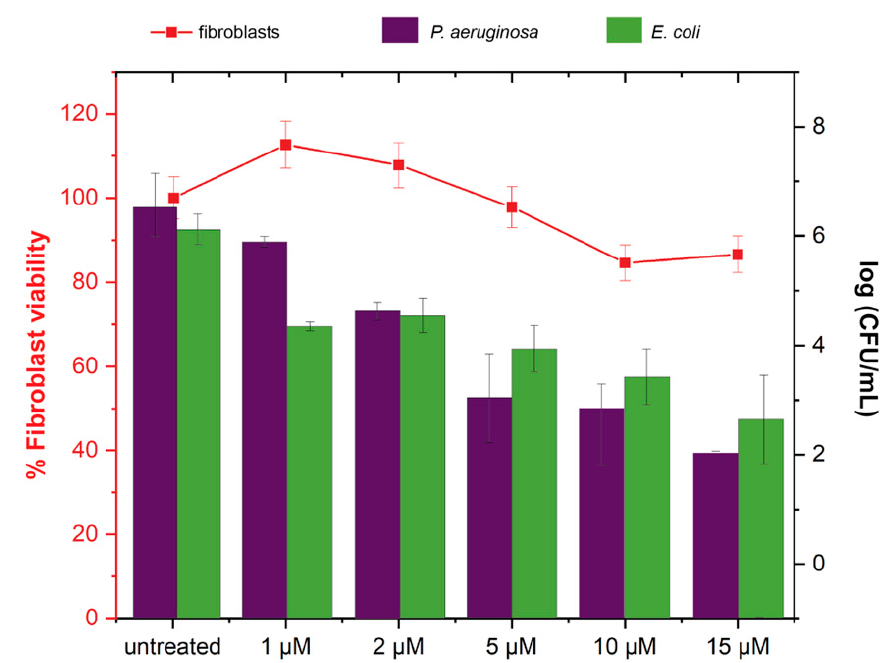
Figure 4. Viability of 3T3 fibroblast cells and E. coli DH5 α + P. aeruginosa ATCC-19660 dual-species biofilms in the co-culture model after 3 h treatment with PNPs. Scatters and lines represent 3T3 fibroblast cell viability. Bars represent log 10 of colony-forming units in biofilms. Limit of quantifica- tion is 2 log 10 . Data are averages of triplicates, with error bars indicating standard deviations.